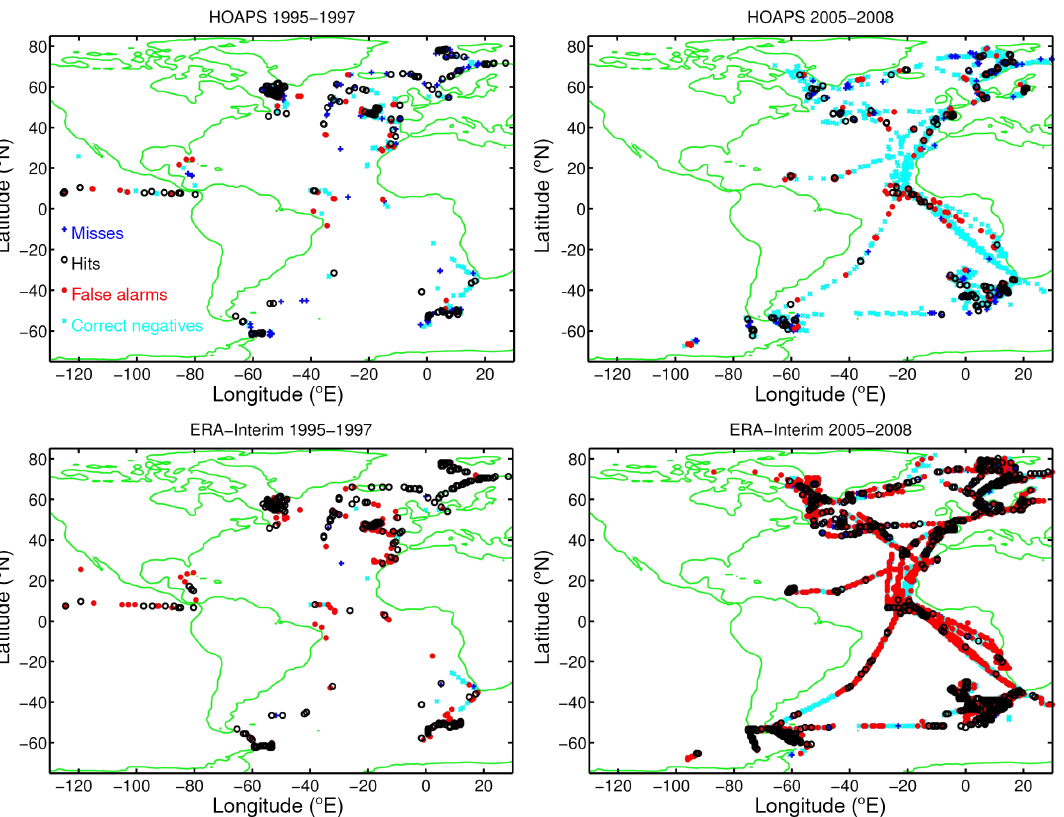
Figure 7. Location of collocated events (left: HOAPS and measurements, right: ERA-Interim and measurements) for the period 1995–1997 (top) and 2005–2008 (bottom). The different coloured symbols indicate misses, hits, false alarms and correct negatives. A lower threshold is not